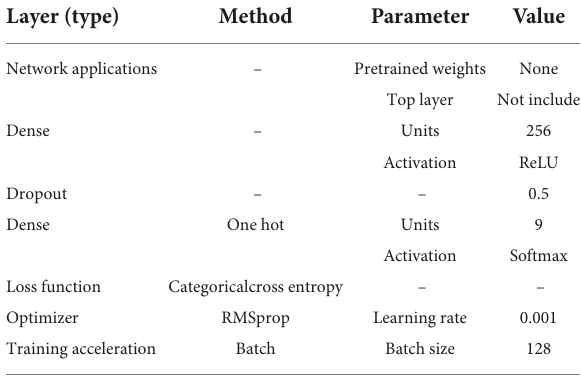
TABLE 9 Structure for network applications.